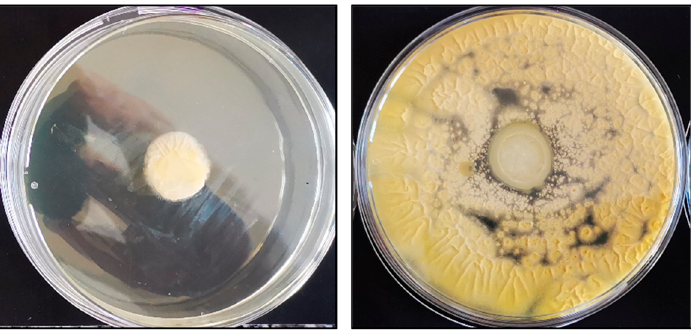
Figure 13. Photographs after microbiology tests.